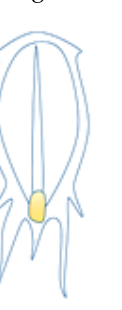
Figure 2. Single salp.